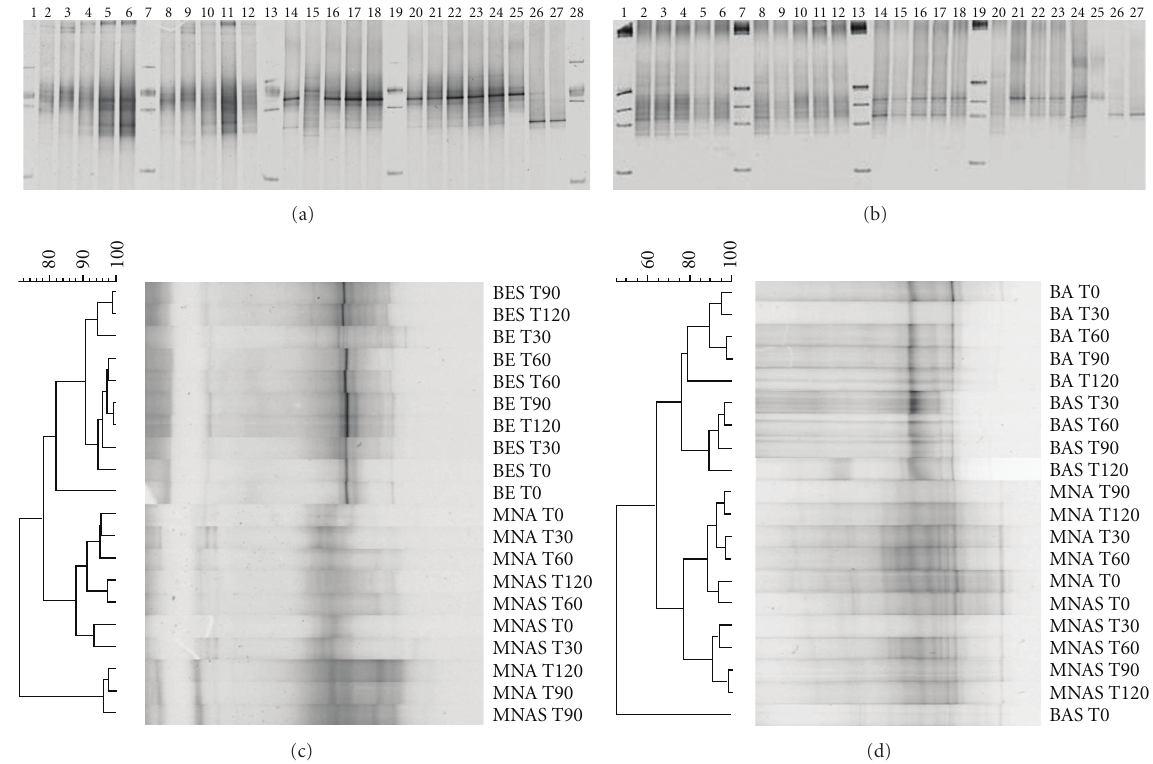
Figure 2: Denaturing gradient gel electrophoresis (DGGE) fingerprints of actinomycetes populations from Cantagalo (a) and Panelas (b) microcosms submitted to di ff erent bioremediation treatments and sampled after 0, 30, 60, 90, and 120 days. Lanes: (1, 7, 13, 19 and 28) 1Kb ladder, (2) MNA T0, (3) MNA T30, (4) MNA T60, (5) MNA T90, (6) MNA T120, (8) MNAS T0, (9) MNAS T30, (10) MNAS